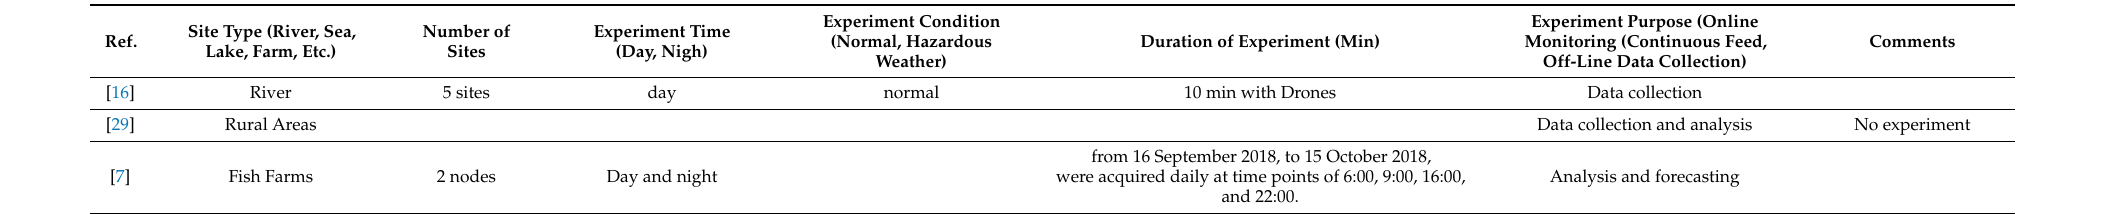
Table 3. Location Analysis of Real-Time